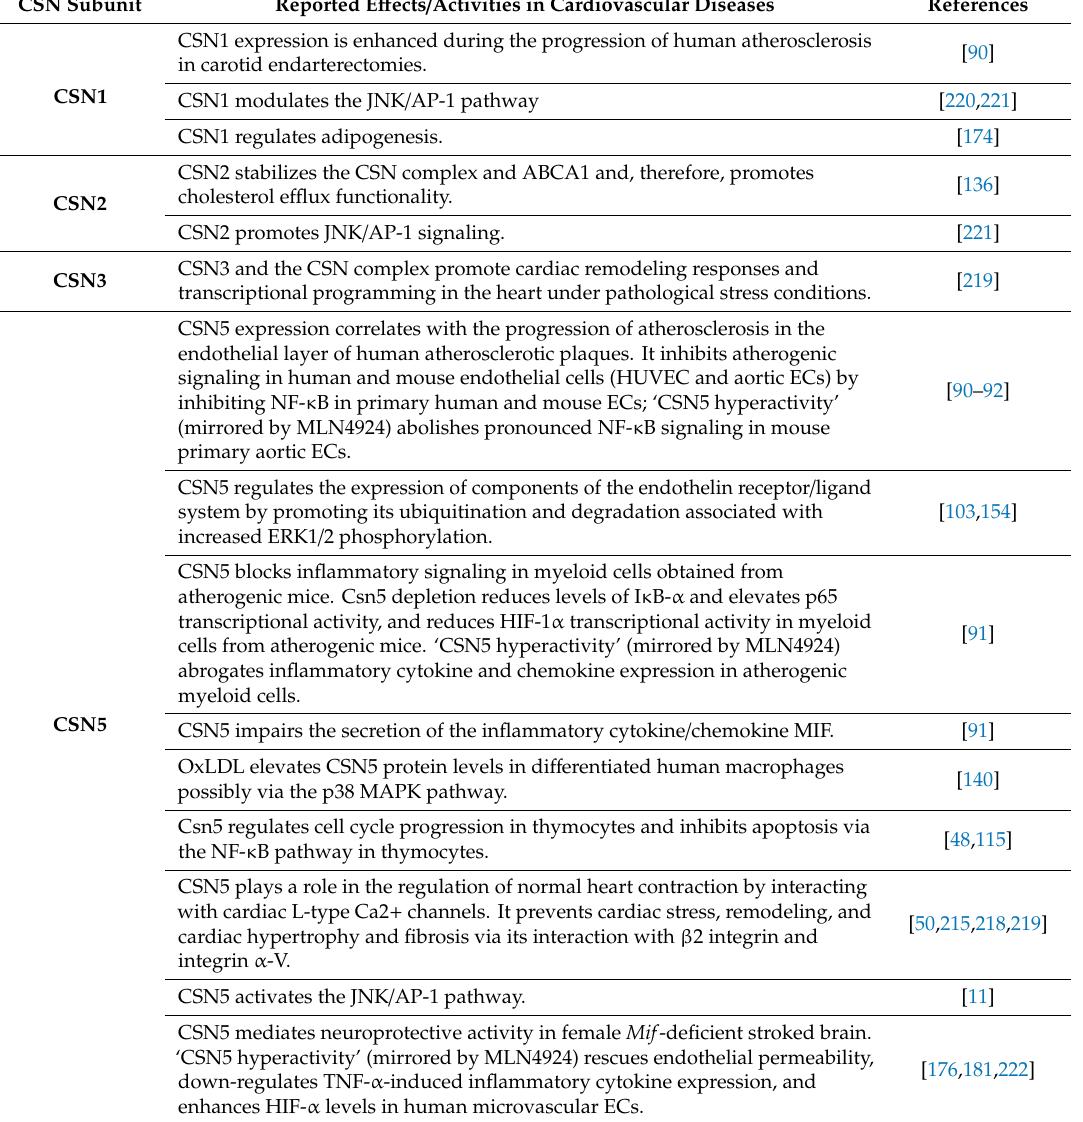
Table 1. Summary of the role of the COP9 signalosome in cardiovascular diseases. CSN